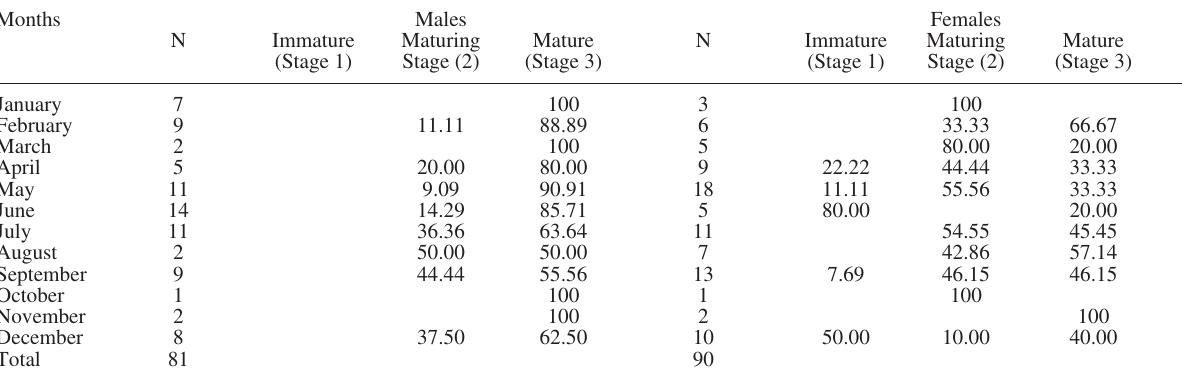
Table 2. – Percentage of distribution of male and female Neorossia caroli according to maturity stages in months. Months